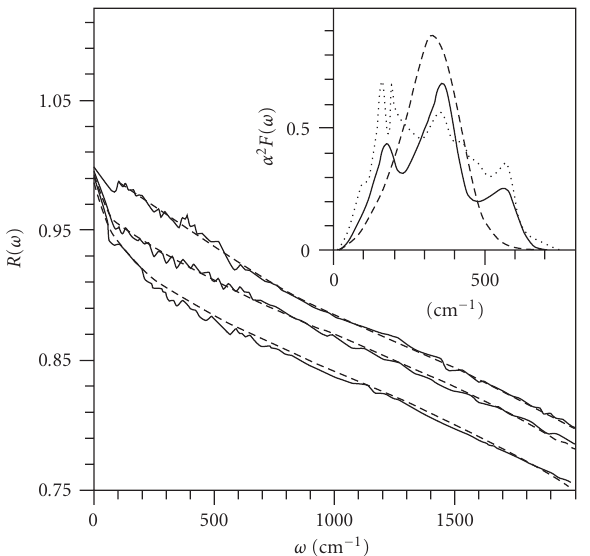
Figure 7: Experimental (solid lines) and calculated (dashed lines) data of R ( ω ) in optimally doped YBCO [105] at T = 100,200,300K (from top to bottom). Inset: the two (solid and dashed lines) ( ω ) F ( ω )’s at T = 100K. The phonon density of reconstructed α 2 tr states F ( ω )—dotted line in the inset. From [33–35].